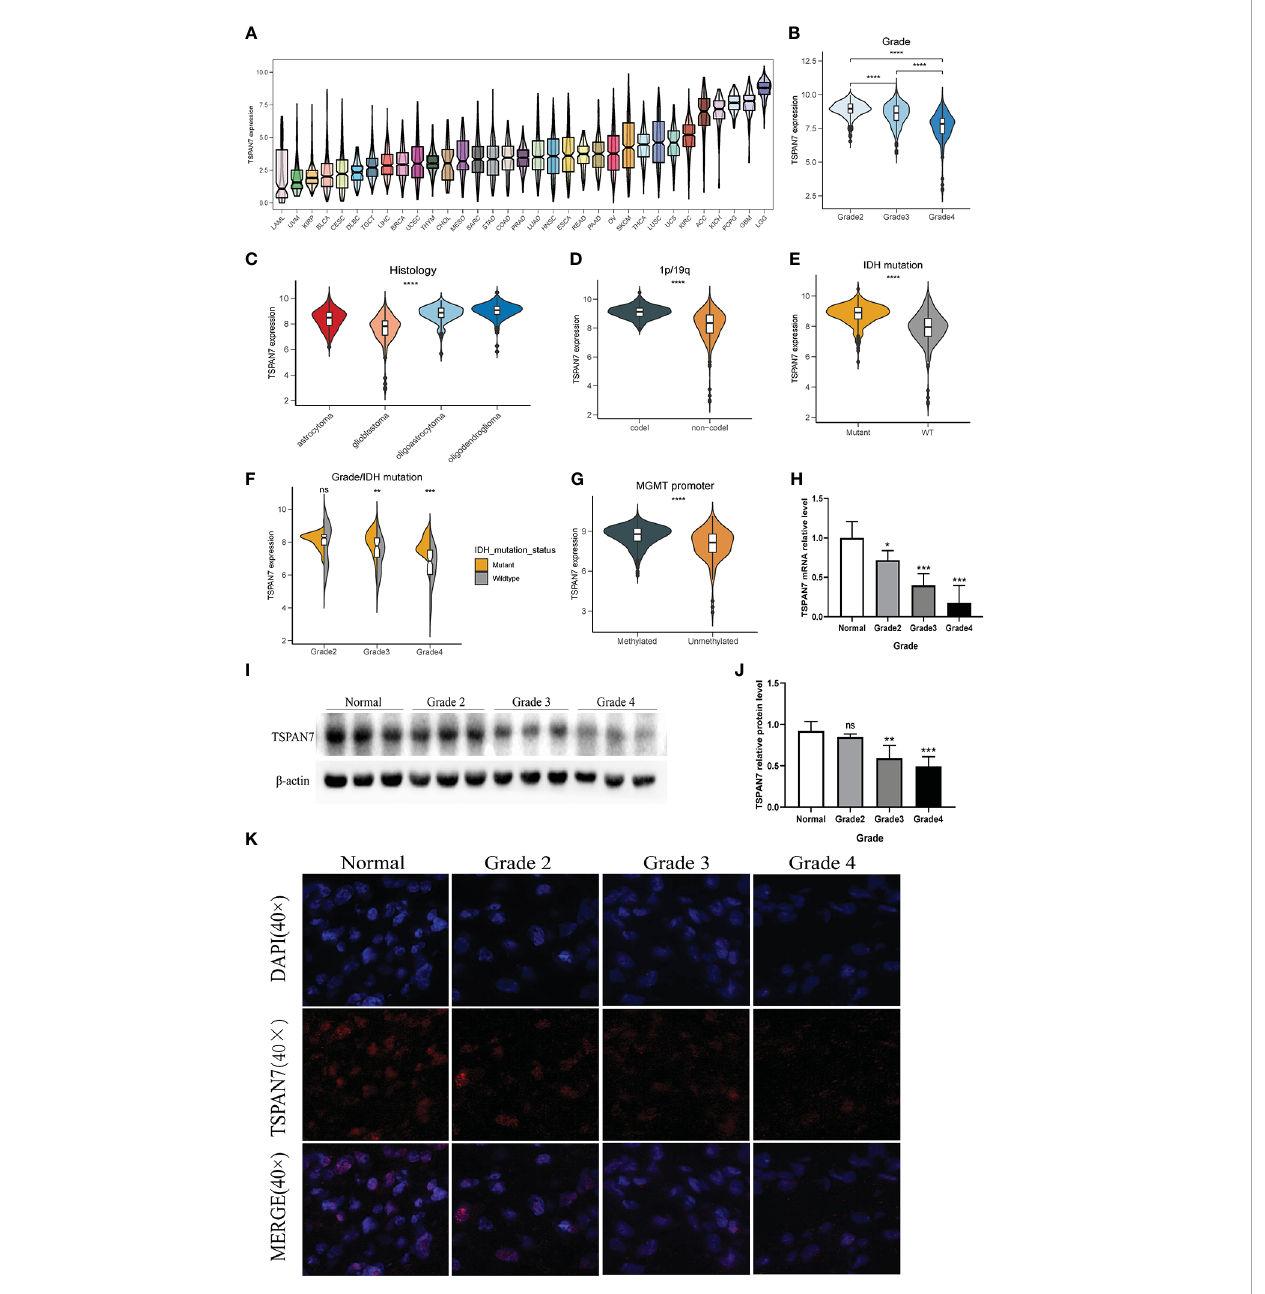
FIGURE 1 Clinical and molecular characteristics of TSPAN7 in gliomas. (A) The expression of TSPAN7 in multiple cancer from TCGA dataset. LAML, acute myeloid leukemia; UVM, Uveal Melanoma; KIRP, kidney renal papillary cell carcinoma; BLCA, bladder urothelial carcinoma; CESC, cervical squamous cell carcinoma and endocervical adenocarcinoma; DLBC, lymphoid neoplasm diffuse large B-cell lymphoma; TGCT, testicular germ cell tumors; LIHC, liver hepatocellular carcinoma; BRCA, breast invasive carcinoma; UCEC, uterine corpus endometrial carcinoma; THYM, thymoma; CHOL, cholangiocarcinoma; MESO, Mesothelioma; SARC, sarcoma; STAD, stomach adenocarcinoma; COAD, colon adenocarcinoma; PRAD, prostate adenocarcinoma; LUAD, lung adenocarcinoma; HNSC, head and neck squamous cell carcinoma; ESCA, esophageal carcinoma; READ, rectum adenocarcinoma; PAAD, pancreatic adenocarcinoma; OV, ovarian serous cystadenocarcinoma; SKCM, skin cutaneous melanoma; THCA, thyroid carcinoma; LUSC, lung squamous cell carcinoma; UCS, uterine carcinosarcoma; KIRC, kidney renal clear cell carcinoma; ACC, adrenocortical carcinoma; KICH, kidney chromophobe; PCPG, pheochromocytoma and paraganglioma; GBM, glioblastoma multiforme; LGG, brain lower grade glioma. B, C The expression of TSPAN7 strati fi ed by WHO pathological grades and types. (D, E) The expression of TSPAN7 in 1p19q codeletion and non-codeletion glioma and IDH mutant and wild-type status. (F) The expression of TSPAN7 in IDH mutation status combined with different pathological grades. (G) The expression of TSPAN7 strati fi ed by MGMT promoter methylation status. (H) The mRNA relative level of TSPAN7 in clinical glioma samples according to different WHO pathological grades. (I, J) Representative images of Western Blot for TSPAN7 in normal brain tissue and different pathological grades. (K) Representative images of IF staining for TSPAN7 in normal brain tissue and different WHO pathological grades of glioma. *p<.05, **p <.01, ***p <.001, ****p <.0001, ns: no